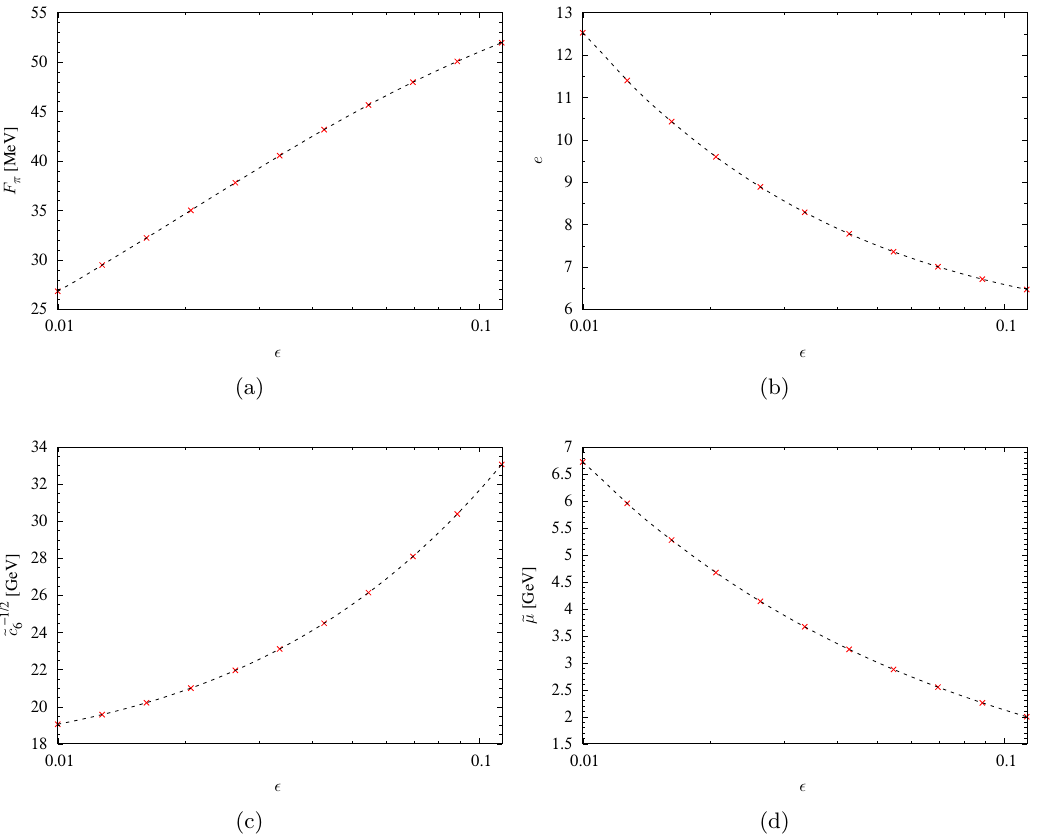
Figure 11 . The Skyrme model parameters (a) F π and (b) e in physical units (MeV) as well as the BPS sector’s coupling constants (c) ˜ c − µ = 1 , m π = 3 , R = (3 π ) 1 3 and ( s, p ) = (1 , 2)